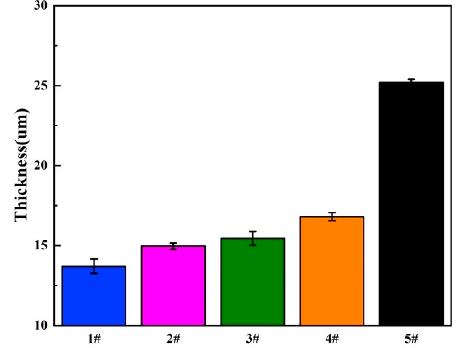
Figure 5. The coating thickness of MAO-WE43 and GelMA / MAO-WE43 samples. 1#: MAO-WE43; 2#: 1GelMA / MAO-WE43; 3#: 5GelMA / MAO-WE43; 4#: 10GelMA / MAO-WE43; 5#: 15GelMA / MAO-WE43. Table 2. Average thicknesses of samples.